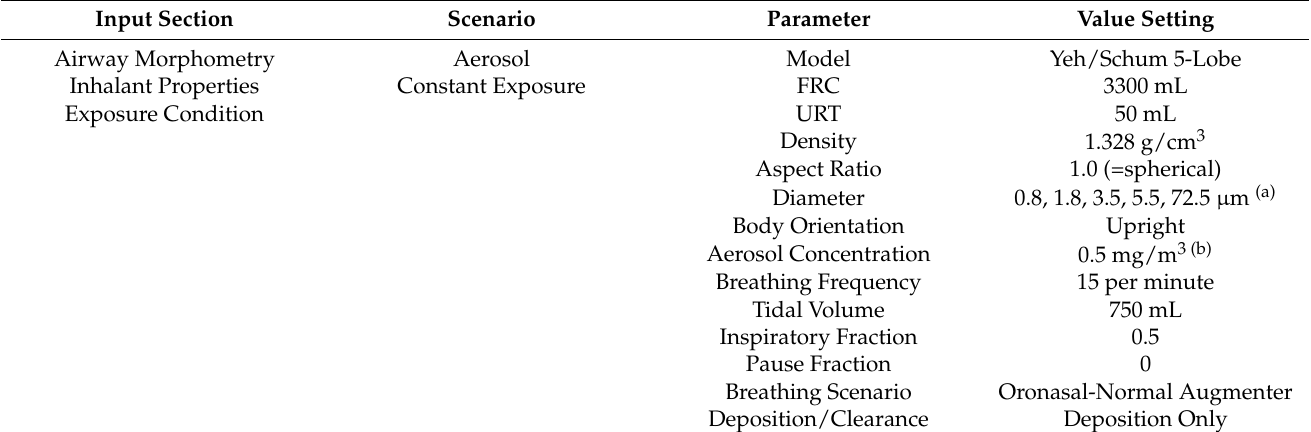
Table 3. MPPD parameter settings for breathing scenario “light